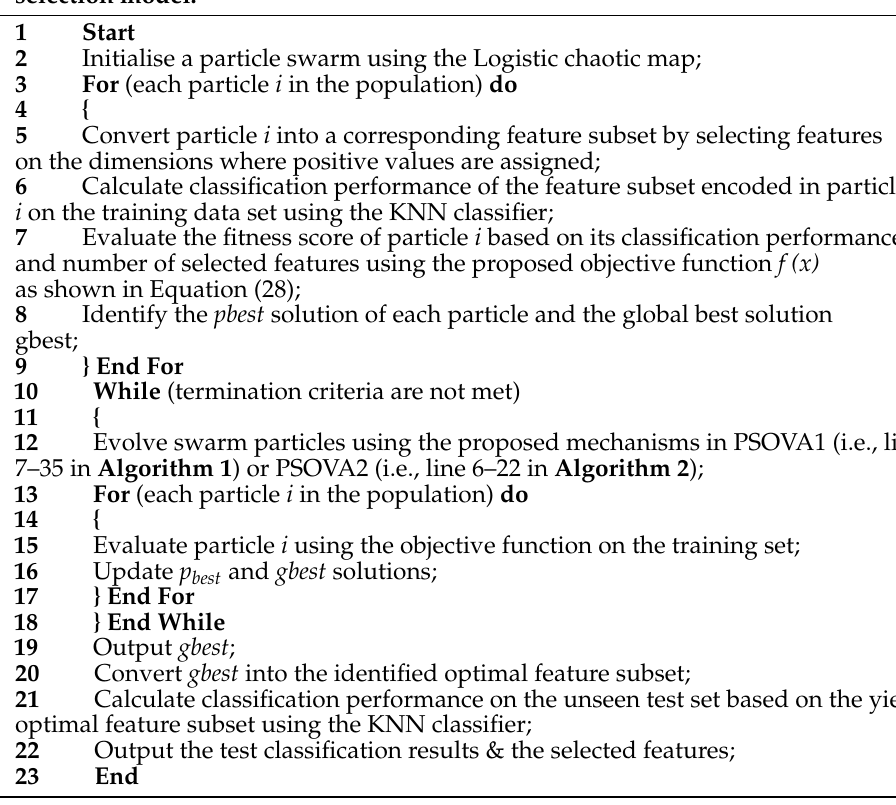
Algorithm 3. The pseudo-code of the hybrid PSOVA1/PSOVA2-KNN feature selection